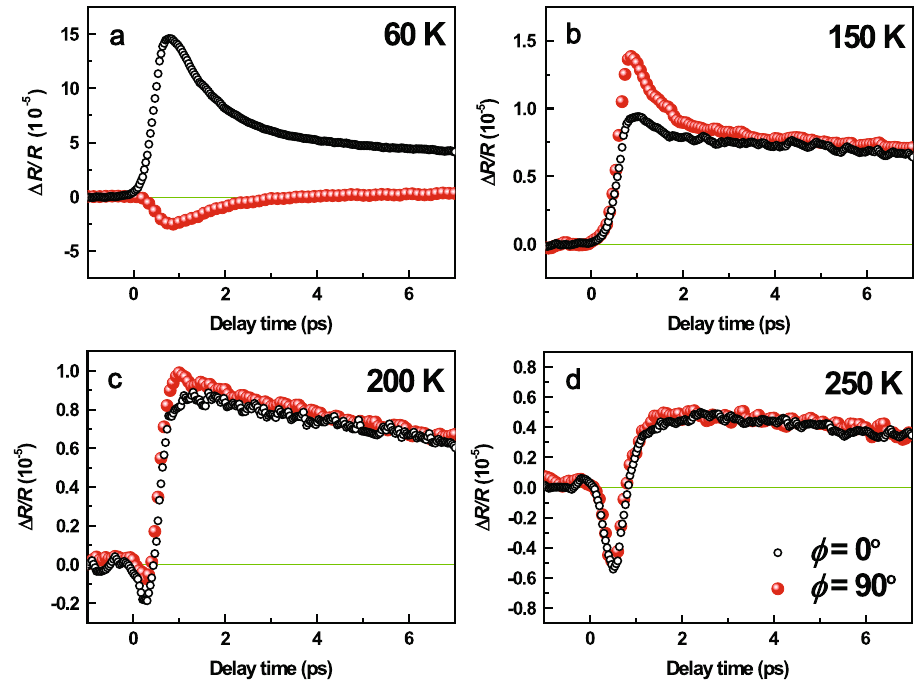
Fig. 2 a – d Δ R / R of an FeSe single crystal with the polarizations of pump and probe beams along ϕ = 0° and 90° at various